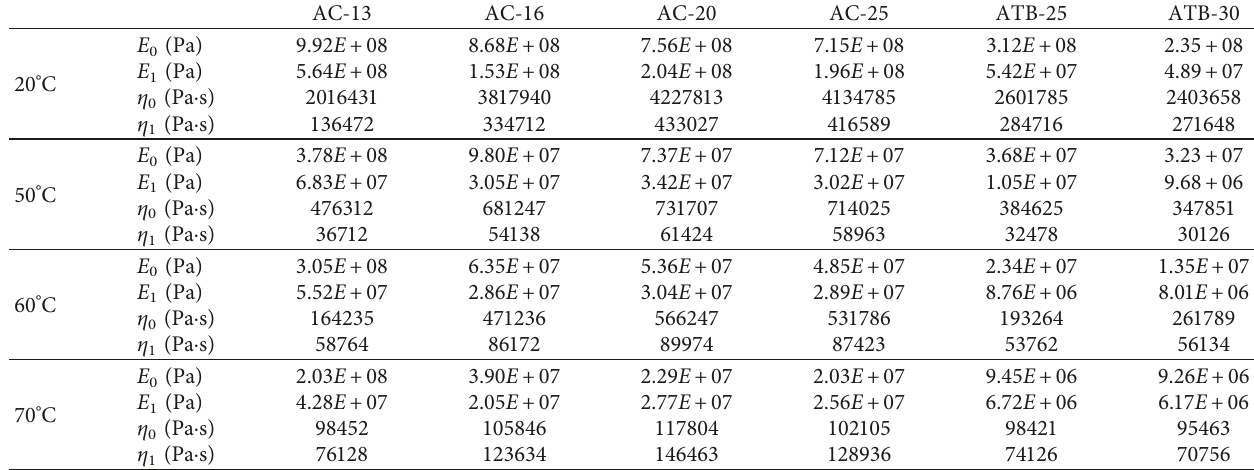
Table 4: Parameters of the Burgers model.